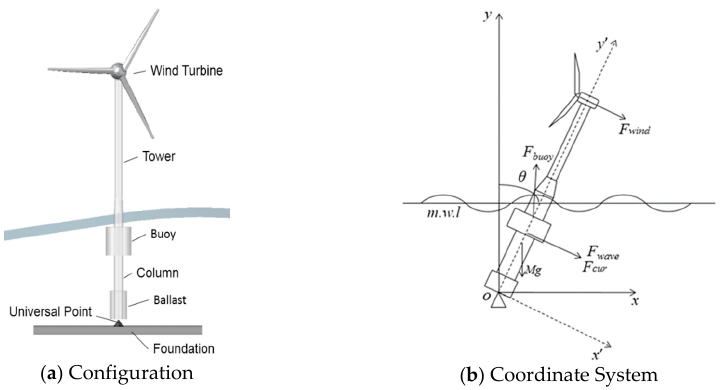
Figure 1. Articulated offshore wind turbine.